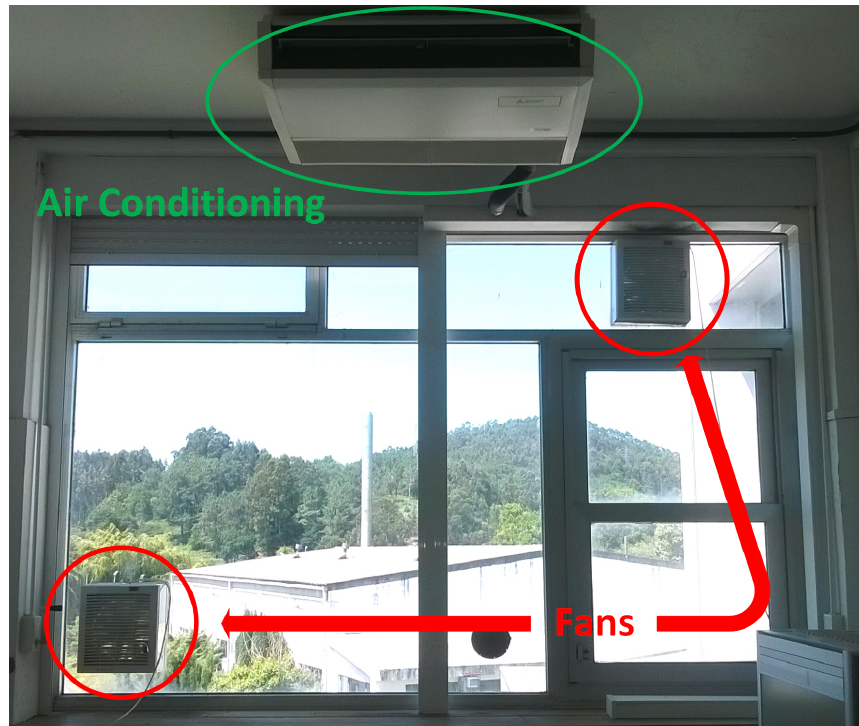
Figure 5. Picture of the measurement room with all systems.